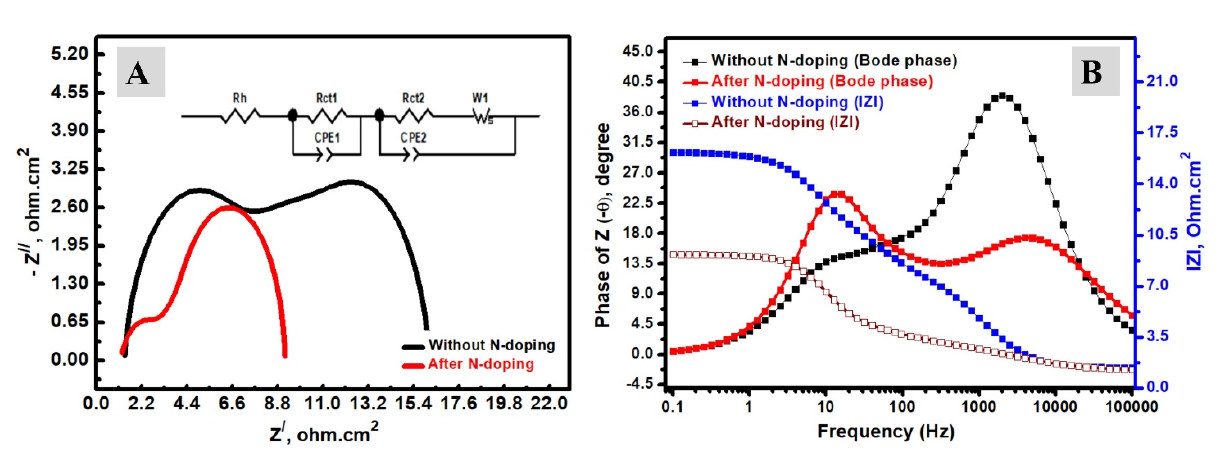
Figure 8. ( A ) EIS analyses of DSCs without and after N-doping of TiO 2 photoanode; ( B ) Bode phase and total impedance data N-doping of TiO 2 photoanode. and total impedance data N-doping of TiO 2